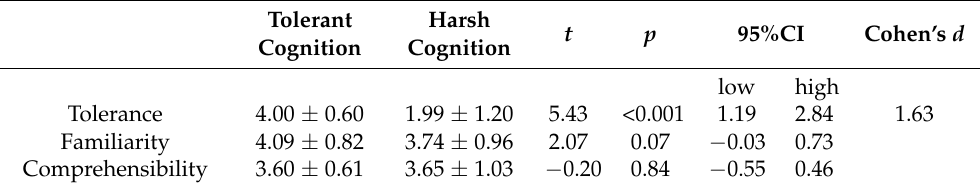
Table 5. The mean rating scores of the words describing different cognition. Tolerant Cognition